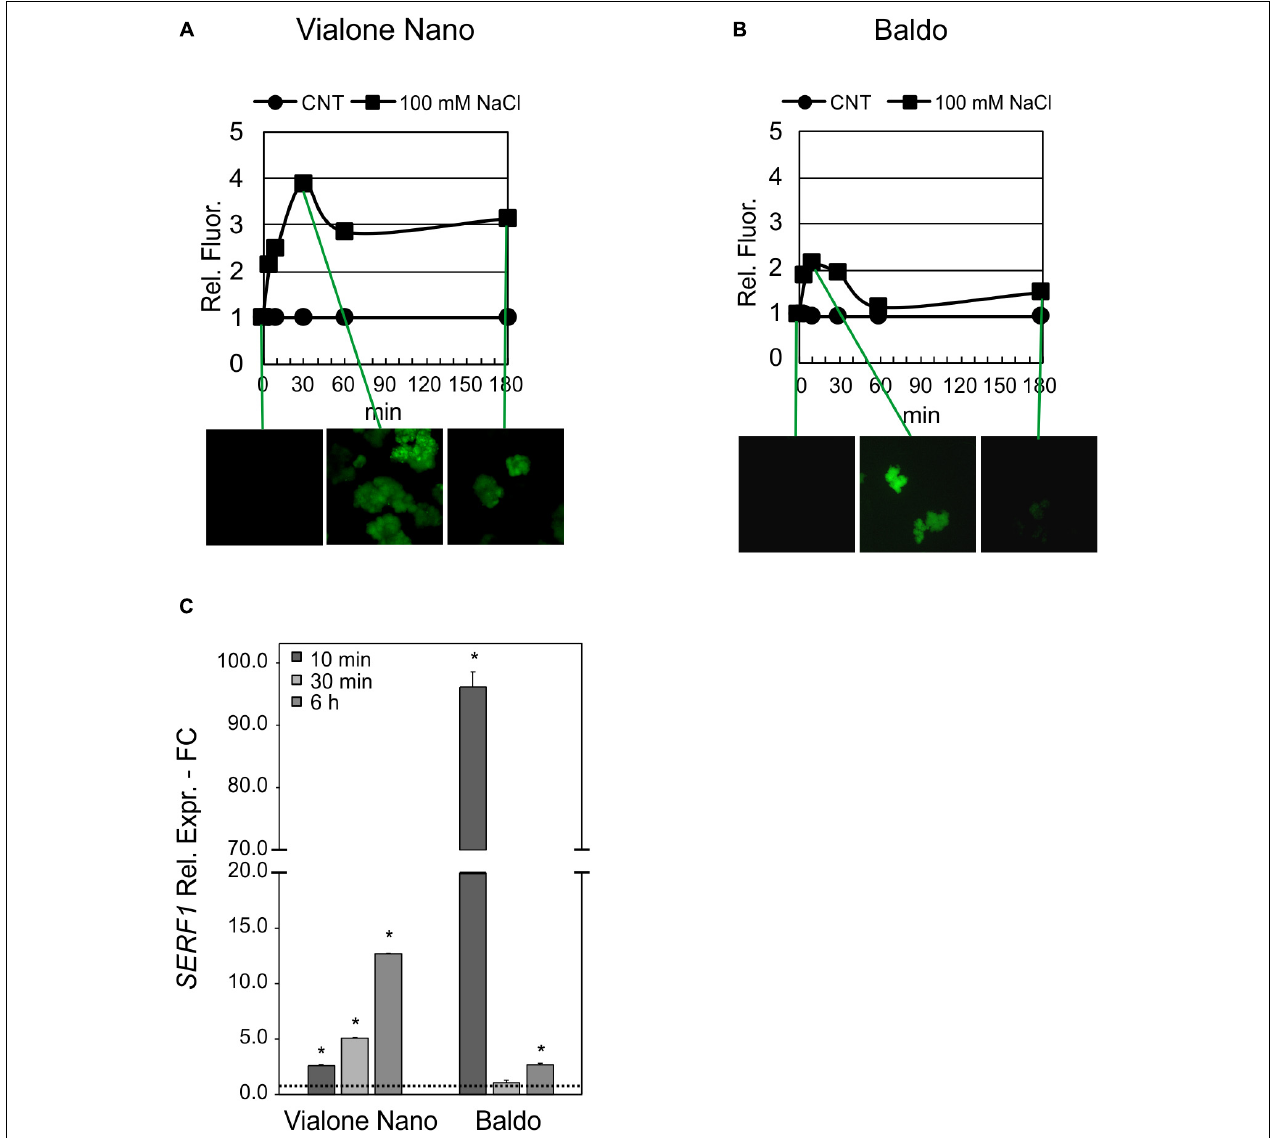
FIGURE 11 | Intracellular H 2 O 2 and signaling in glucose/GOX treated cells. The internal H 2 O 2 production was imaged by using the DHR123 fluorescent dye (A,B) and the expression profile of SERF1 (C) . Insets are representative images of stained cells at different timepoints. Values represent the mean ± SE of three independent experiments at least in duplicate. The asterisk indicates values that are significantly different from those of untreated cells according to Wilcoxon–Mann–Whitney’s test ( p <